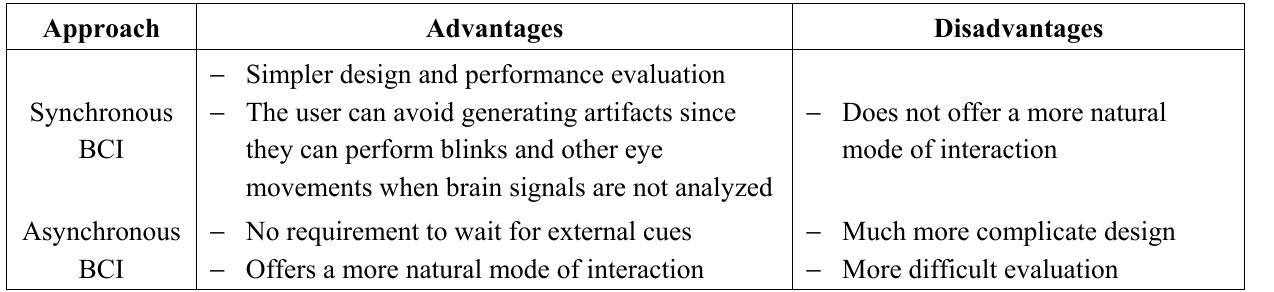
Table 5. Main differences between synchronous and asynchronous